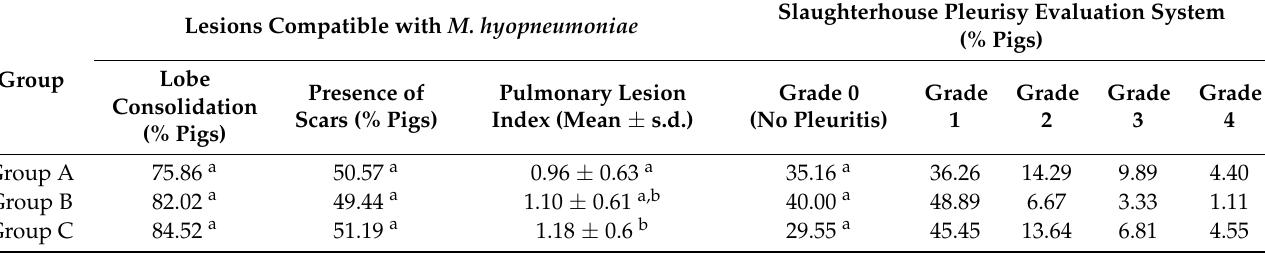
Table 3. Results of the evaluation of lung